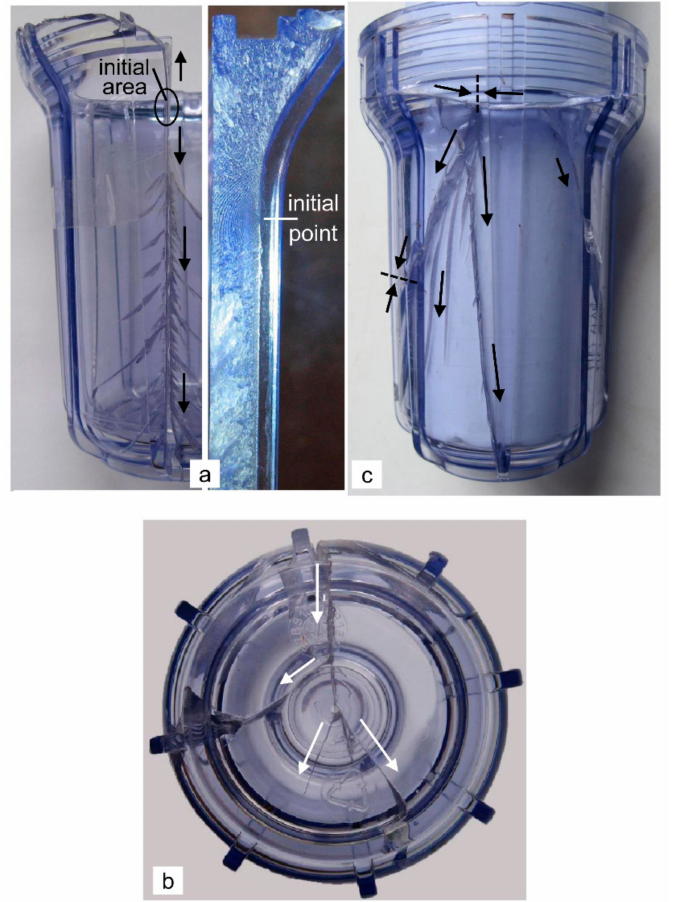
Figure 3. Specific characteristics of the initiation and propagation of the cracks in the sample of series A ( a ) the location of the initiation and downwards growth of the primary crack at the rib [2] ( b ) branching the primary crack in the middle of the base [2] ( c ) the junction site of the two oppositely growing horizontal cracks and the branching of the newly formed downwards-growing crack on the rear side of the filter housing [2]; the arrows indicate the direction of the crack